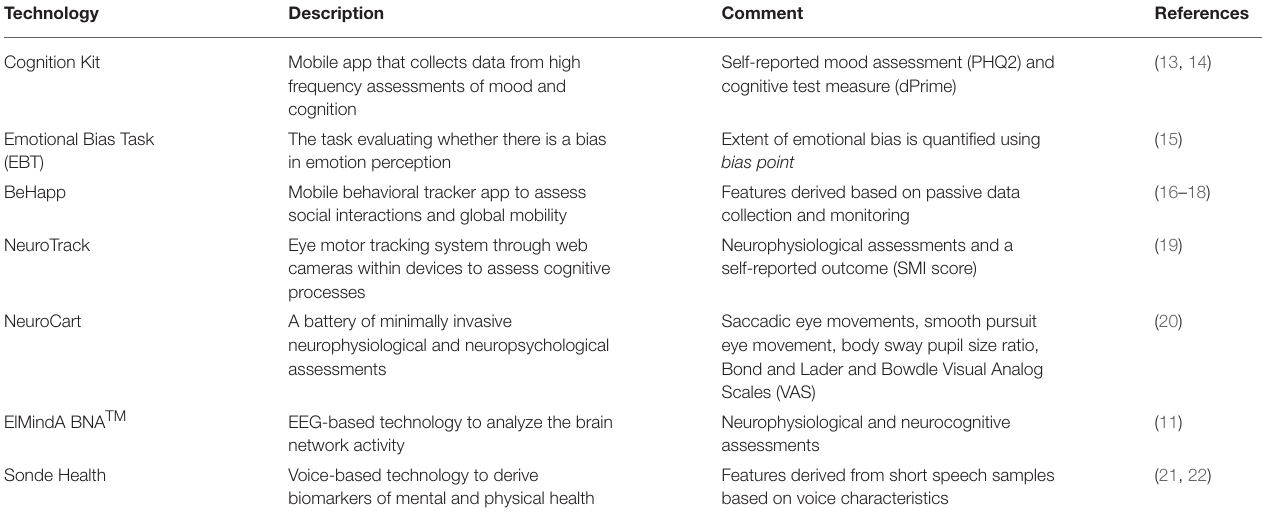
TABLE 2 | Digital technologies assessed in the